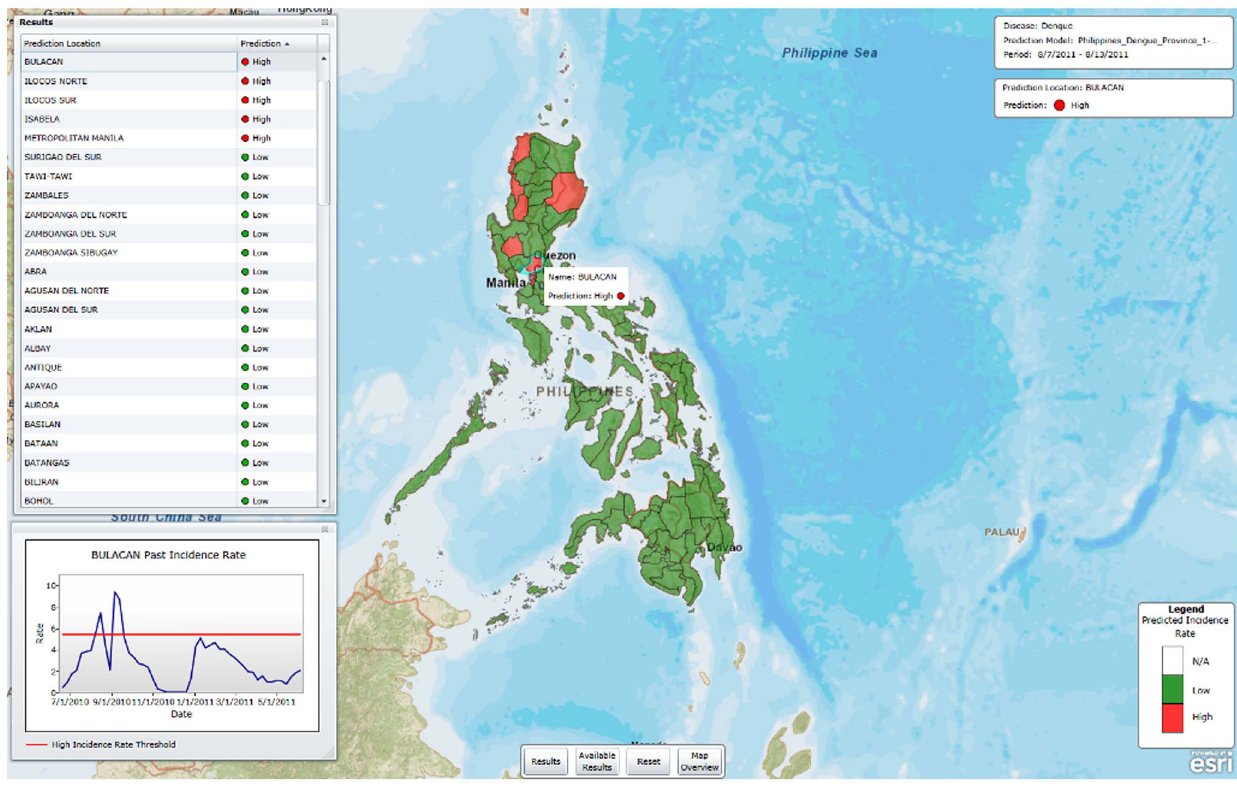
Figure 7. Four-week ahead prediction for the Philippines for the week 8/7–8/13/2011.